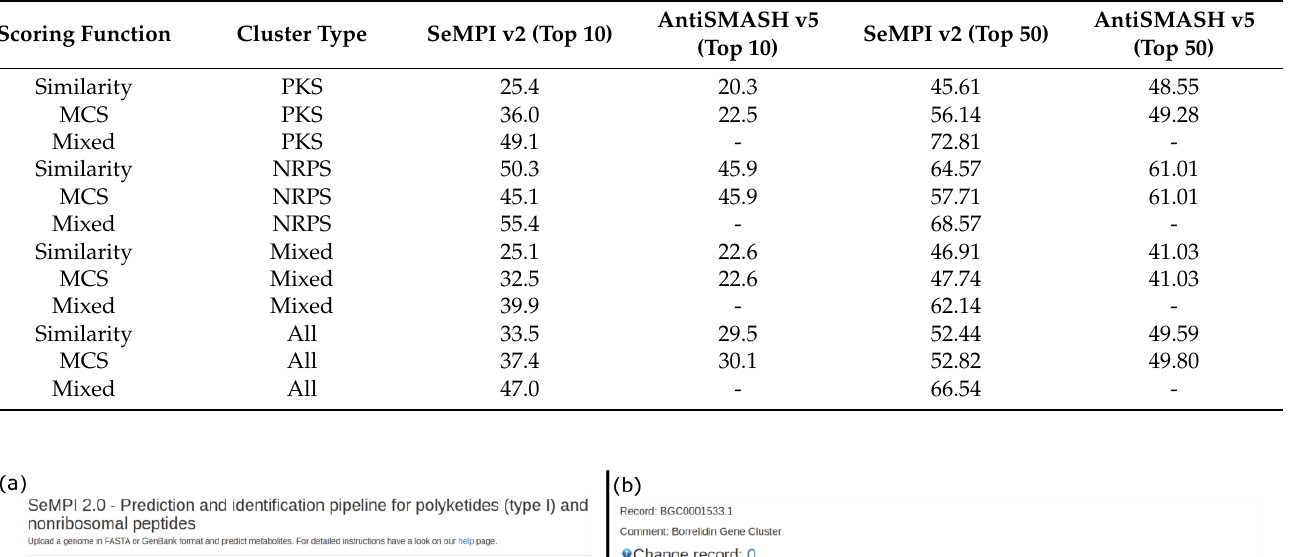
Table 11. Percentage of Top 10 and Top 50 ranked instances of true SMs based on different scoring functions. The mixed scoring is based on the parameter weights determined in Section 2.5.2.